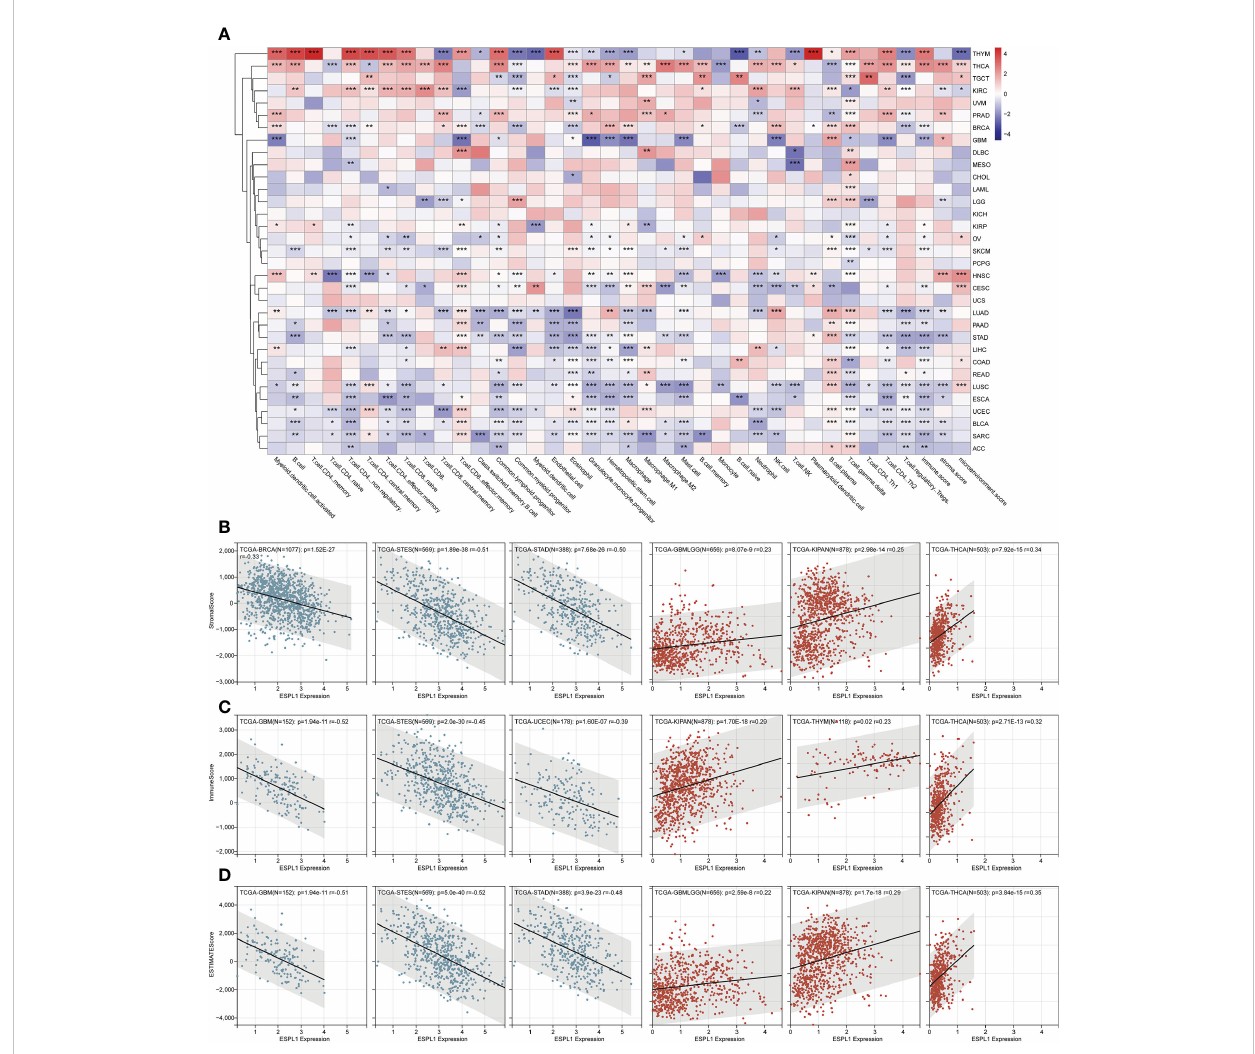
FIGURE 4 The effect of ESPL1 on TME in pan-cancers. (A) Correlation between ESPL1 and TME cells by xCELL algorithm. Representative results of correlation analysis between ESPL1 expression and immune score (B) , stromal score (C) and ESTIMATE score (D) by ESTIMATE algorithm (Three most positive correlations versus three most negative correlations). *p<0.05, **p<0.01, ***p<0.001. TME, tumor